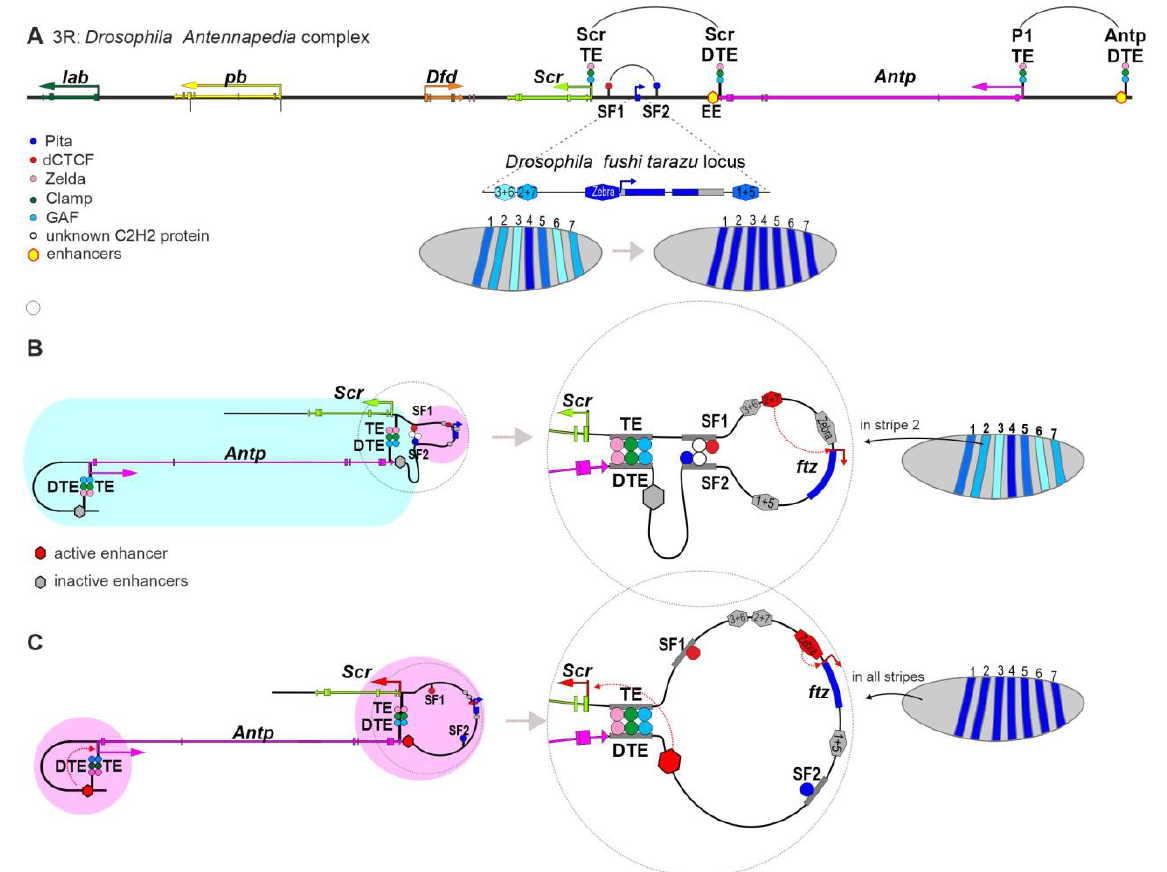
Figure 4. Model of transcription regulation for the pair-rule gene ftz and the Scr gene from ANT-C. ( A ) Schematic representation of ANT-C and the regulatory region of the ftz gene. Only the enhancers, insulators, and tethering elements described in the text are indicated. ( B ) Transcription regulation model of the endogenous ftz in stripe 7 of early embryos. Active and inactive chromatin zones are marked in pink and blue, respectively. The interaction between the SF1 and SF2 insulators allows for autonomic regulation of the ftz gene. ( C ) Transcription regulation model of the endogenous ftz and Scr genes in 5 – 6 h embryos. The interaction between the tethering elements allows for effective activation of the Scr and Antp promoters by their early enhancers.